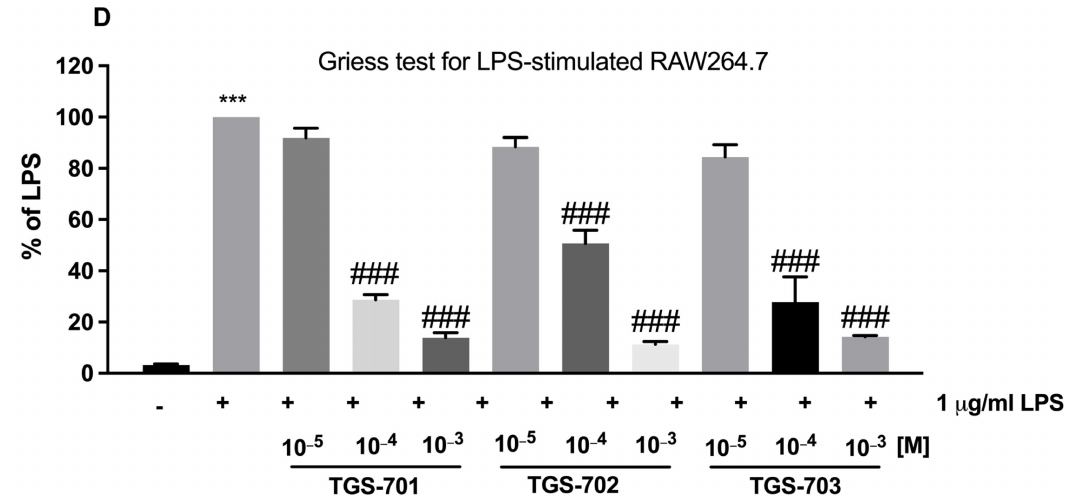
Figure 1. Neutral red uptake test ( A , B ) and Griess test ( C , D ) for RAW264.7 macrophages treated with TGS compounds. ## p < 0.01, ### p < 0.001 vs. control; *** p < 0.001 vs. 1 µ g/mL lipopolysaccharide